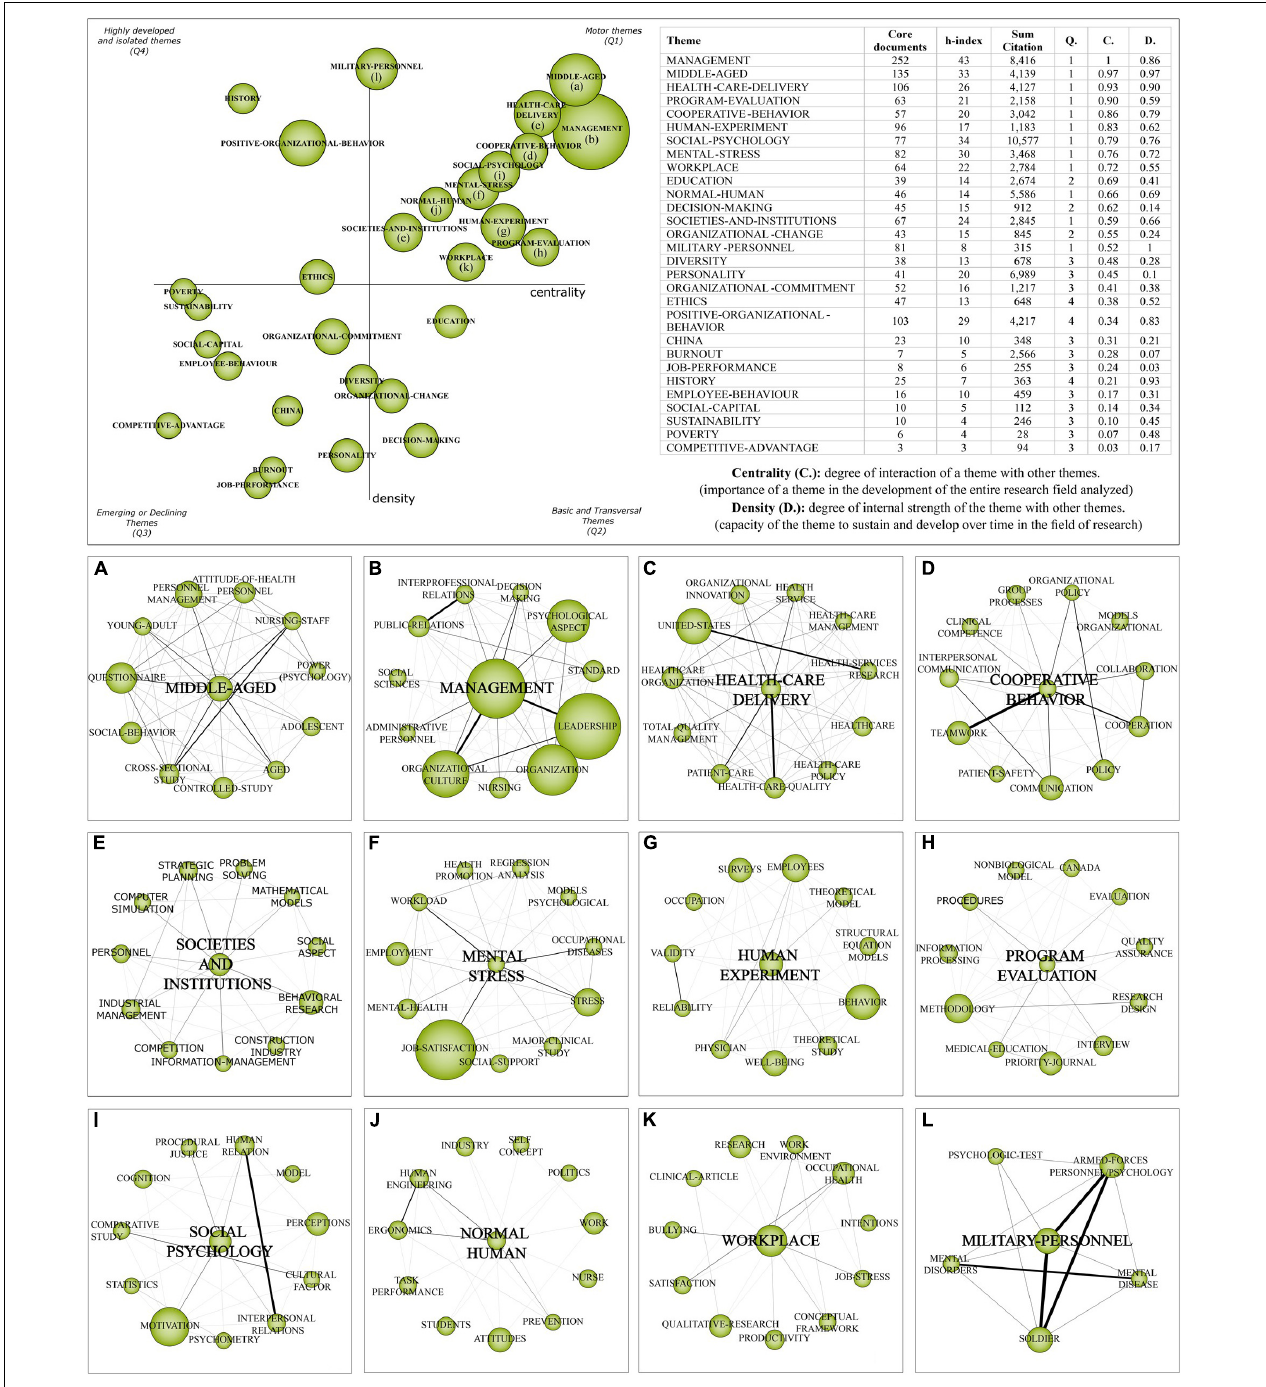
FIGURE 3 | Strategic diagram and thematic network structure of the motor themes (1919-2019). (A) middle aged, (B) management, (C) healthcare delivery, (D) cooperative behavior, (E) societies and institutions, (F) mental stress, (G) human experiment, (H) program evaluation, (I) social psychology, (J) normal human, (K) workplace, and (L) military